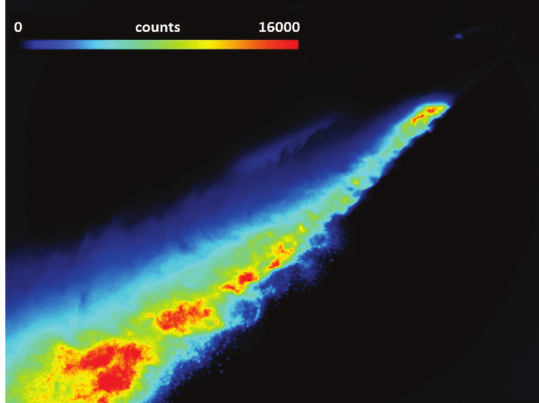
Fig. 5. Instantaneous LIF image after background subtraction